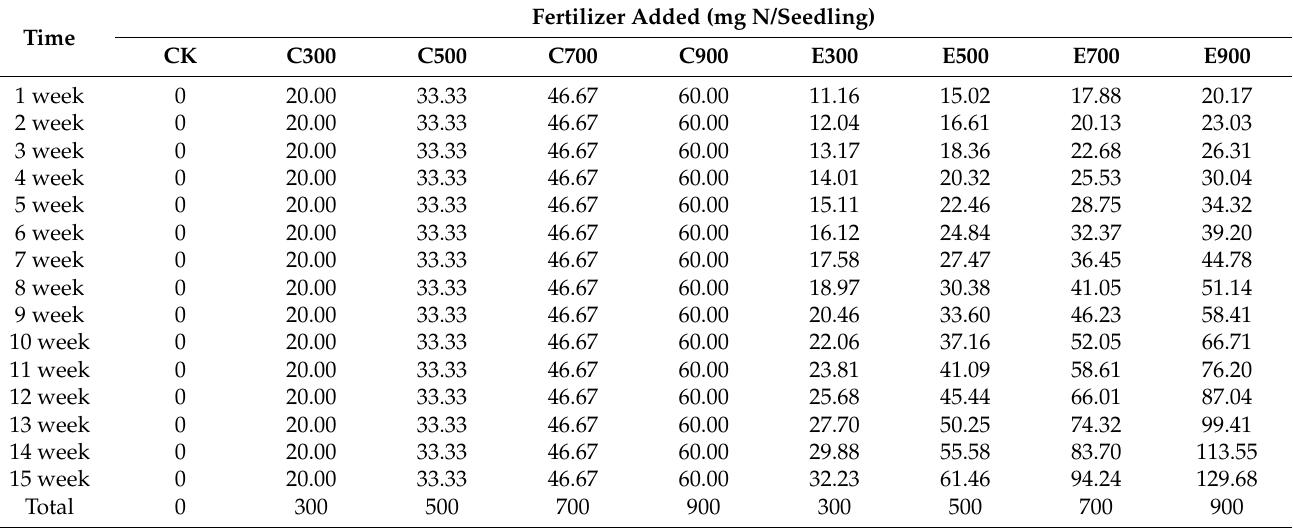
Table 1. The design of fertilizer